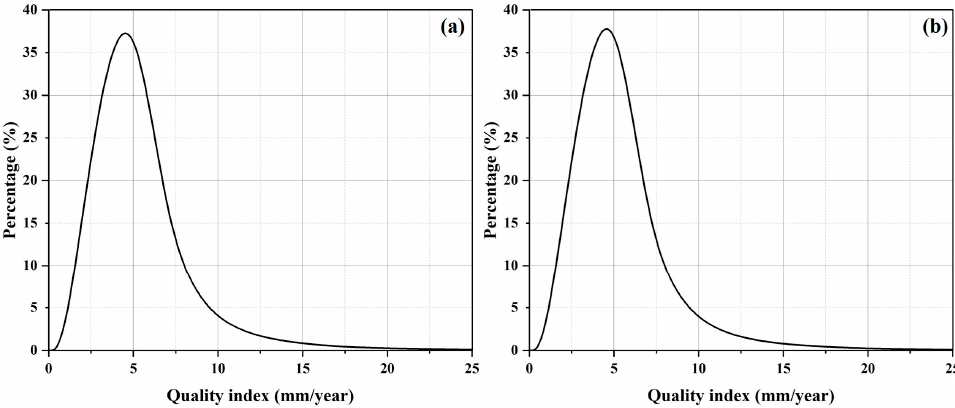
Figure 8. ( a ). Probability density of PS point subsidence information quality for January 2018 to